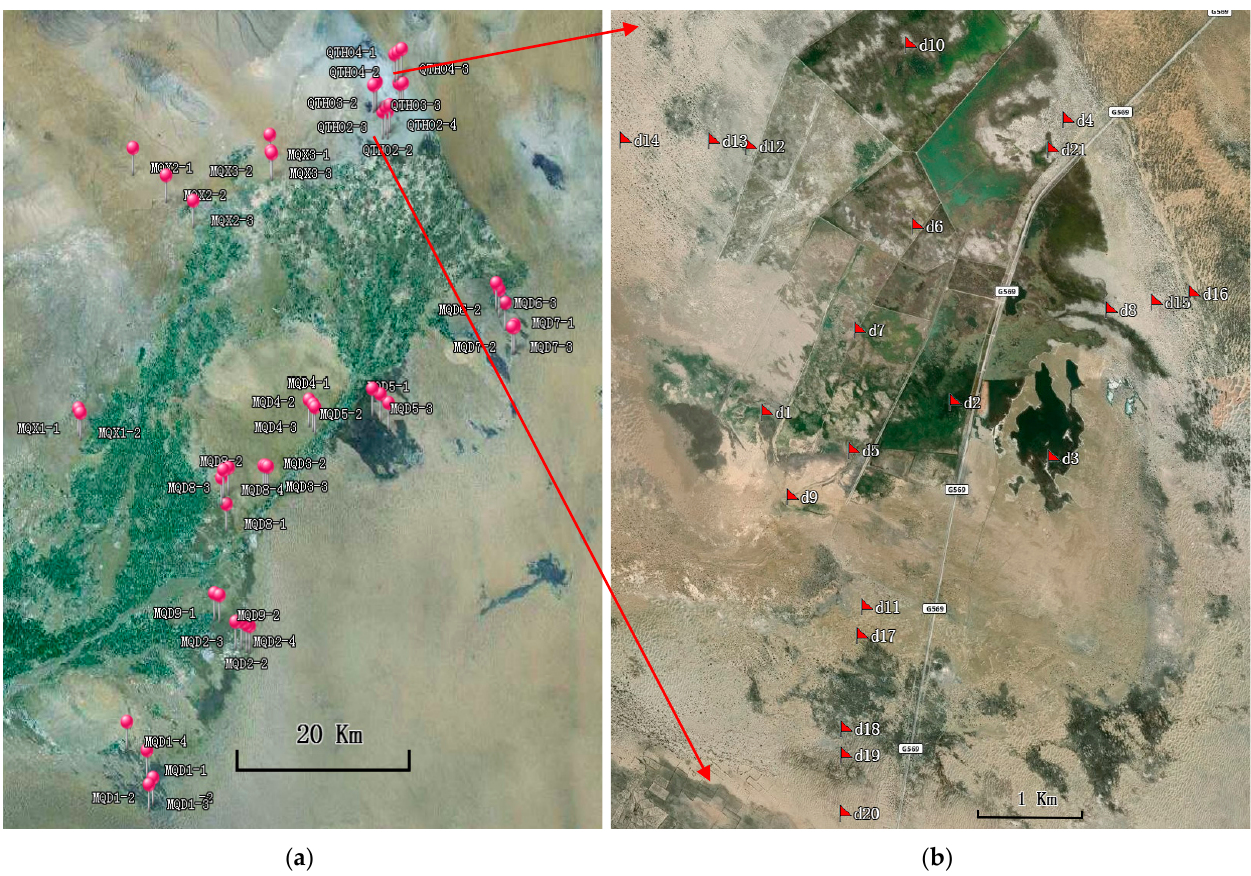
Figure 3. The map of field survey points. ( a ) Field ecological vegetation–groundwater–soil comprehensive investigation; ( b ) in situ monitoring sites of groundwater.